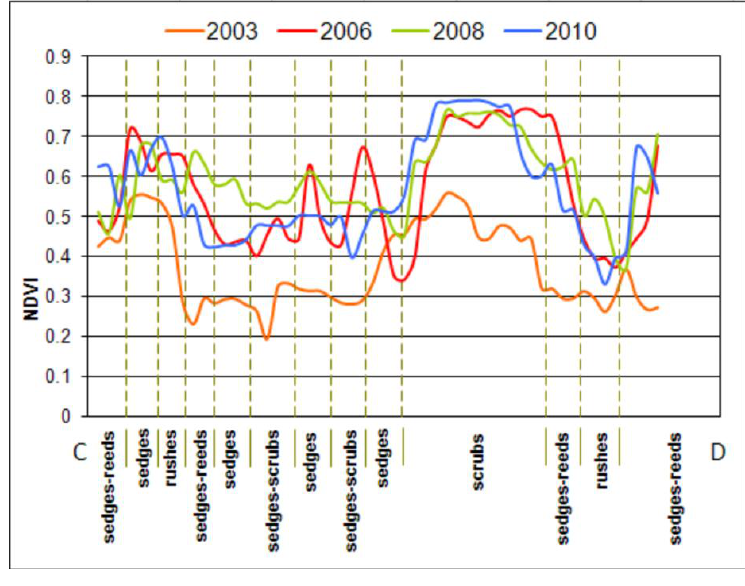
Figure 18. NDVI values along the transect C–D calculated from MERIS